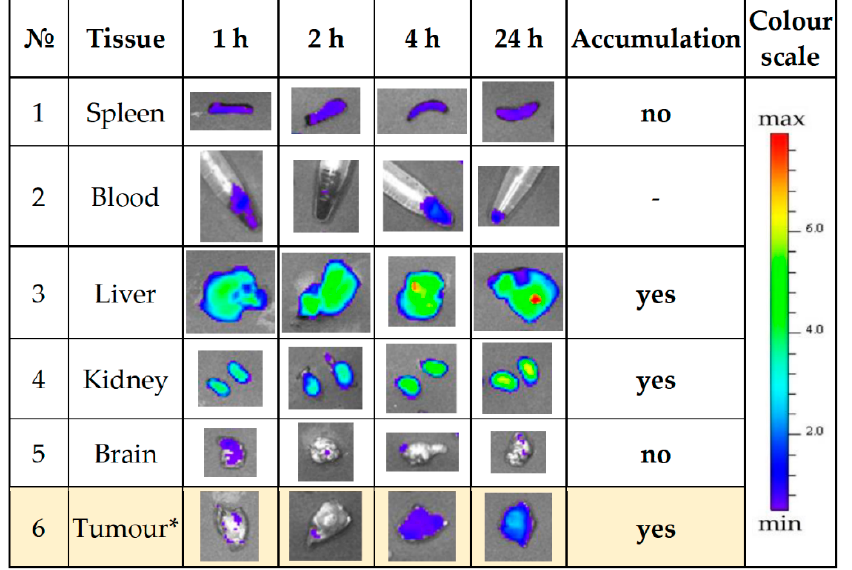
Figure 14. Images illustrating Cy7 fluorescence intensity in the organs and the blood samples of the most representative animal from each time point. * The tumour was excised alongside a piece of surrounding tissue and is visible in the centre of the image as a round sphere.